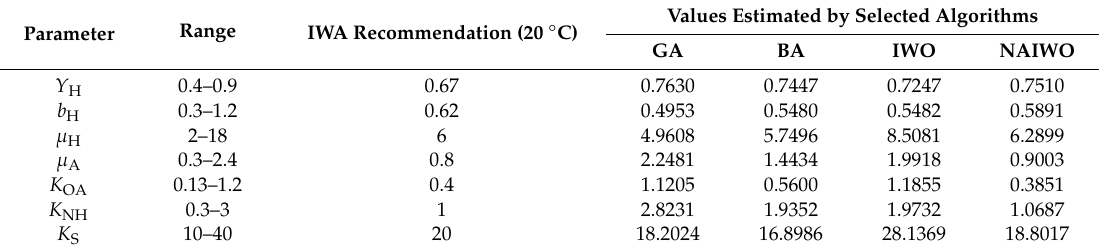
Table 3. Estimated results of seven parameters of ASM1 for Wushan County Wastewater Treatment Plant (WC-WWTP).